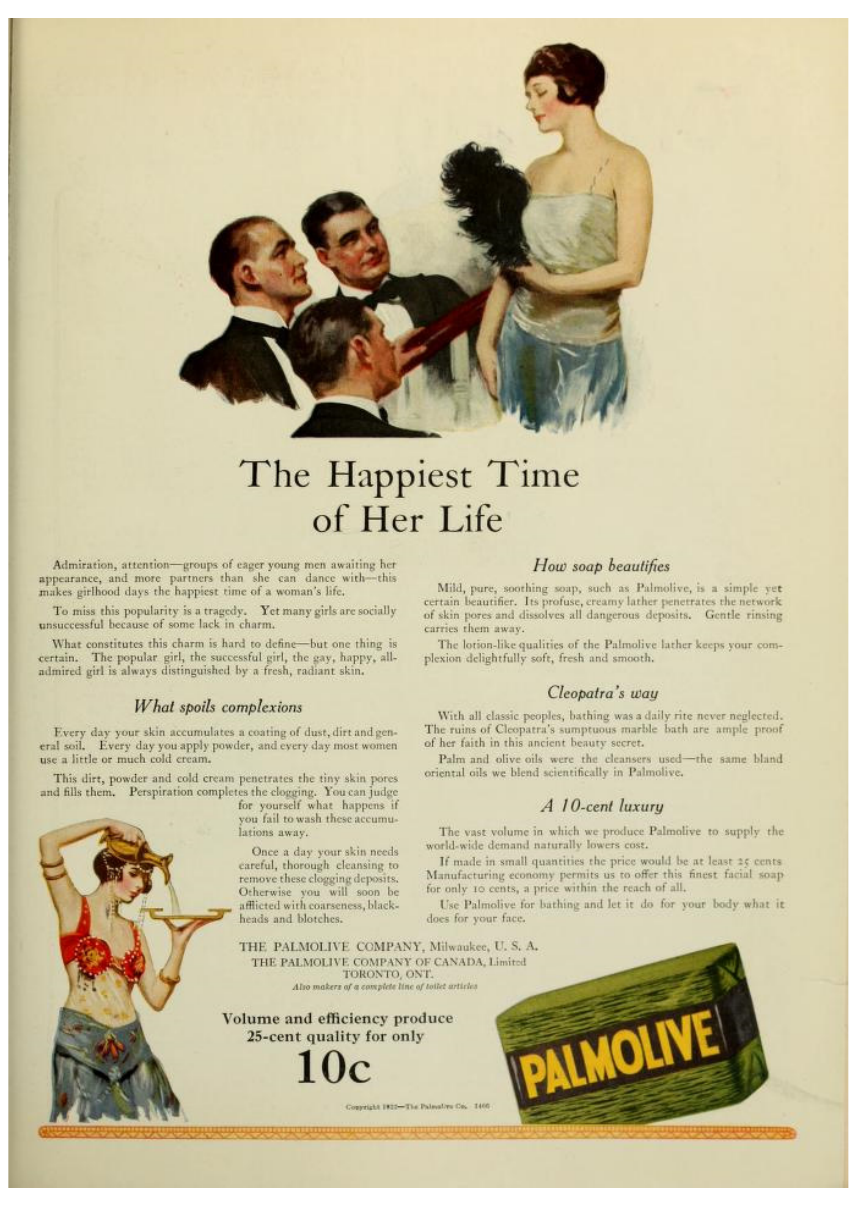
Figure 5. Palmolive Advertisement, Photoplay Magazine , March 1922, vol. 21, no. 4., p. 75.